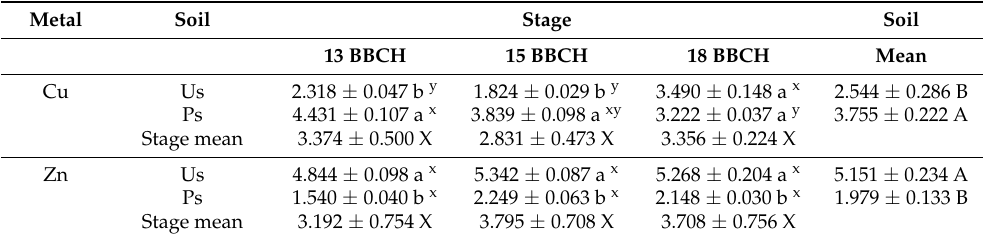
Table 8. TF of Cu and Zn in different development stages of S. perfoliatum grown in heavy metal Ps and Us.